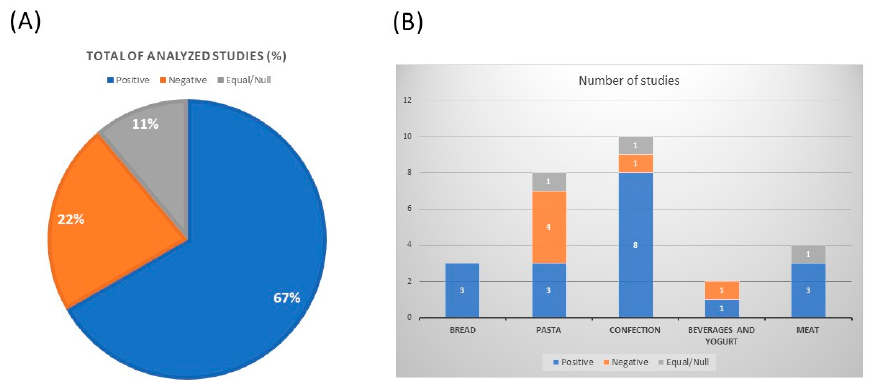
Figure 1. Sensorial analysis of functional food products developed by incorporation of underutilized grains. ( A ) Percentage of the analyzed studies. A total of 27 studies that evaluated the sensorial analysis of developed products were summarized in this section of the review from the literature search (PubMed and Web of Science). The reported sensory attributes were categorized as positive, negative, or null outputs in the final formulation. ( B ) Classification of the resulting sensorial attributes in each food group including bread, pasta, confectionary, meat, beverages, and yogurt. Table 2. Sensorial analysis of functional foods formulated with addition of underutilized grains.